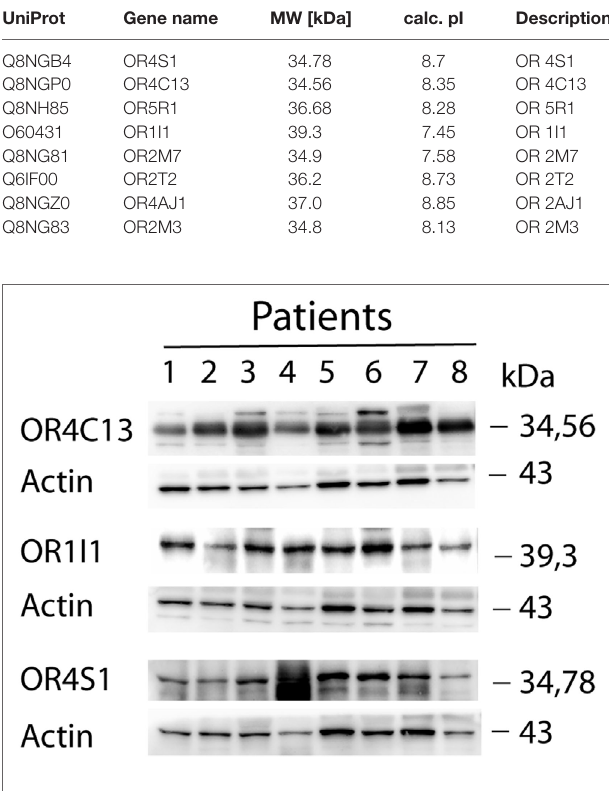
FigUre 1 | Western blot analysis of OR4S1, OR4C13, and OR1I1 protein levels in seminal plasma from fertile